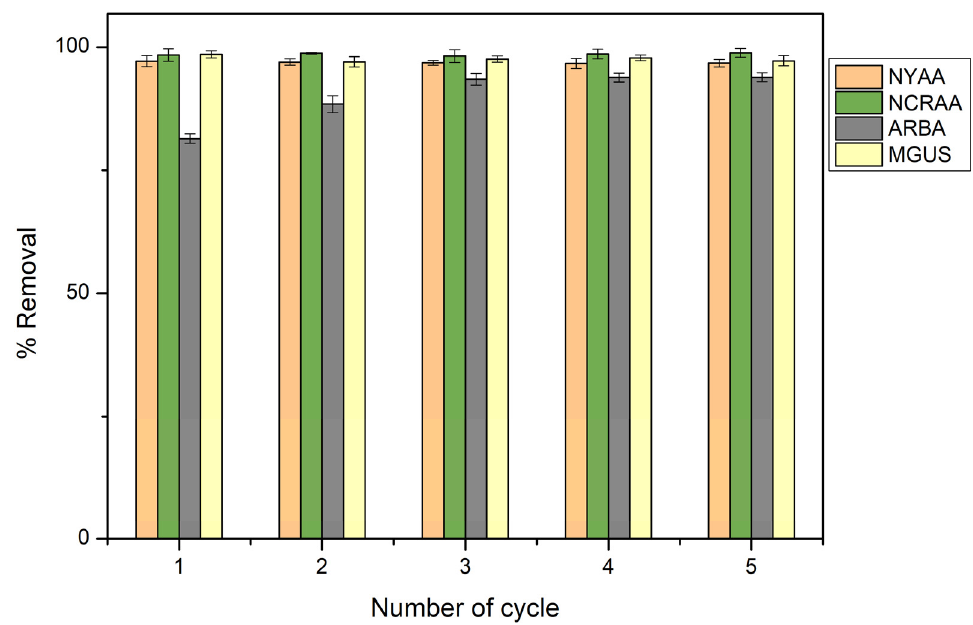
Figure 6. Effect of the number of regeneration cycles on the percentage removal of dyes (NYAA: Novacron Yellow on acidic alumina; NCRAA: Novacron cherry red on acidic alumina; ARBA: Alizarin red on basic alumina; MGUS: methyl green on used silica).